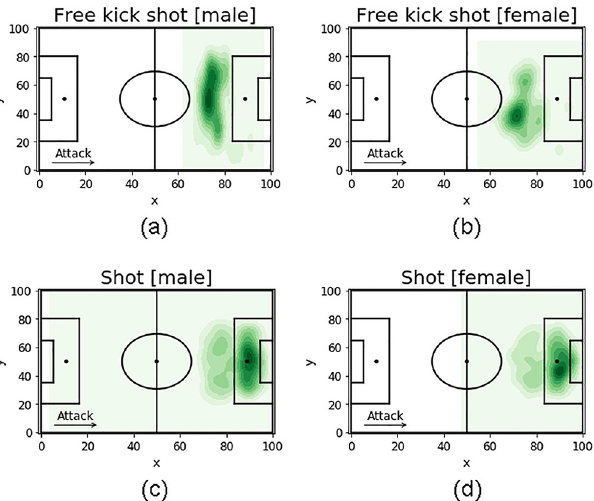
Fig 2. Heatmaps describing the pitch zones from where free-kick shots and shots in motion are more likely to be made by male and female players, computed as the kernel estimate of the first grade intensity function, where the event points are the free-kick shots and the shots in motion, and the football field is the region of interest. The darker is the green, and the higher is the number of free-kick shots and shots in motion in that field zone. The pitch length (x) and width (y) are in the range [0, 100], which indicates the percentage of the field starting from the left corner of the attacking